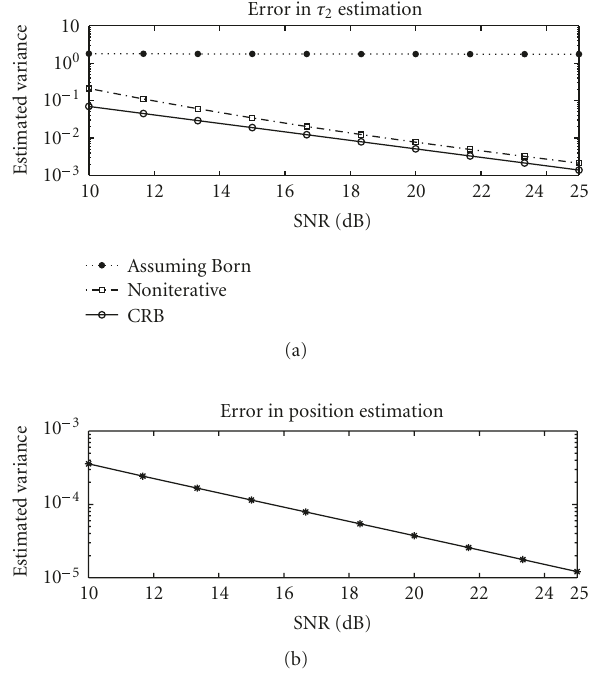
Figure 7: Variance (logarithmic scale) of the estimate of the scat- tering amplitude and the position of target 2 under significant mul- tiple scattering for both the noniterative estimation algorithm and the Born-approximated estimate (36). The targets are located at the positions X 1 = ( X 1 = − 1, Y 1 = − 6) and X 2 = ( X 2 = 1, Y 2 = − 6). Also shown is the CRB of the estimation of the real part of the scat- tering potential. The plot shows the average after 50 instances of random